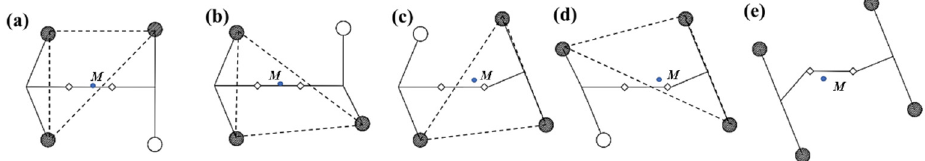
Figure 9. Turning gait; ( a – e ) five movements.